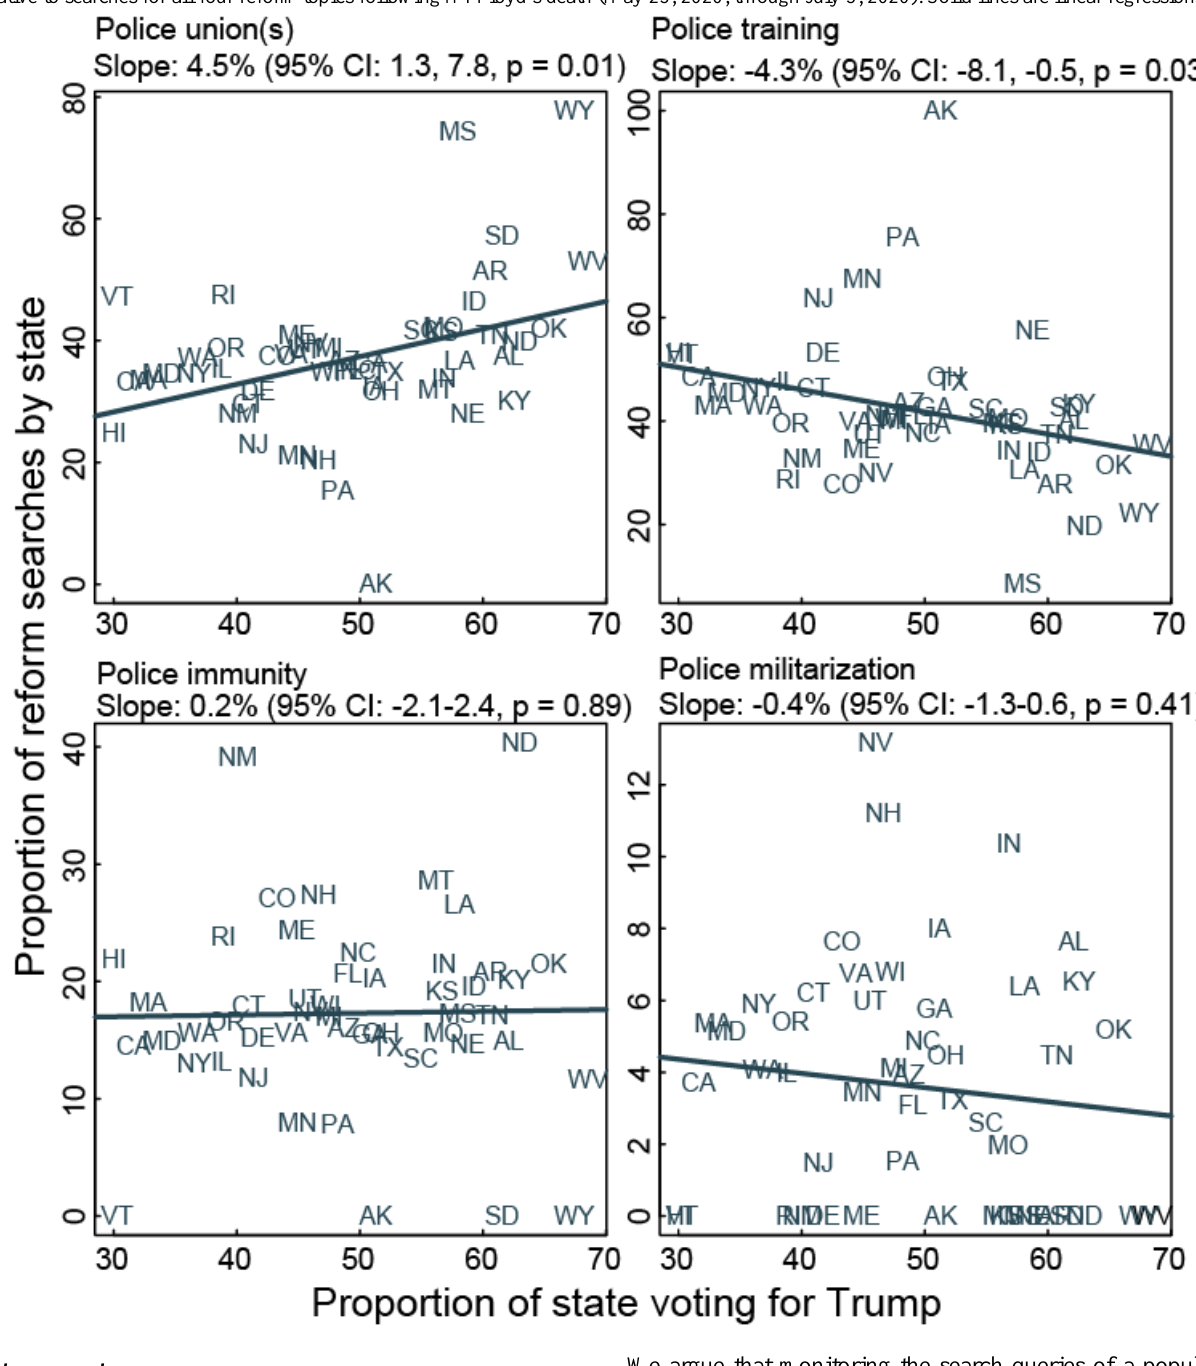
Figure 5. Internet searches for specific police reforms and electoral support for President Donald Trump. Figure shows the proportion of a state voting for Trump in the 2016 election against the proportion of searches for “police” and (A) “immunity,” (B) “union(s),” (C) “training,” or (D)